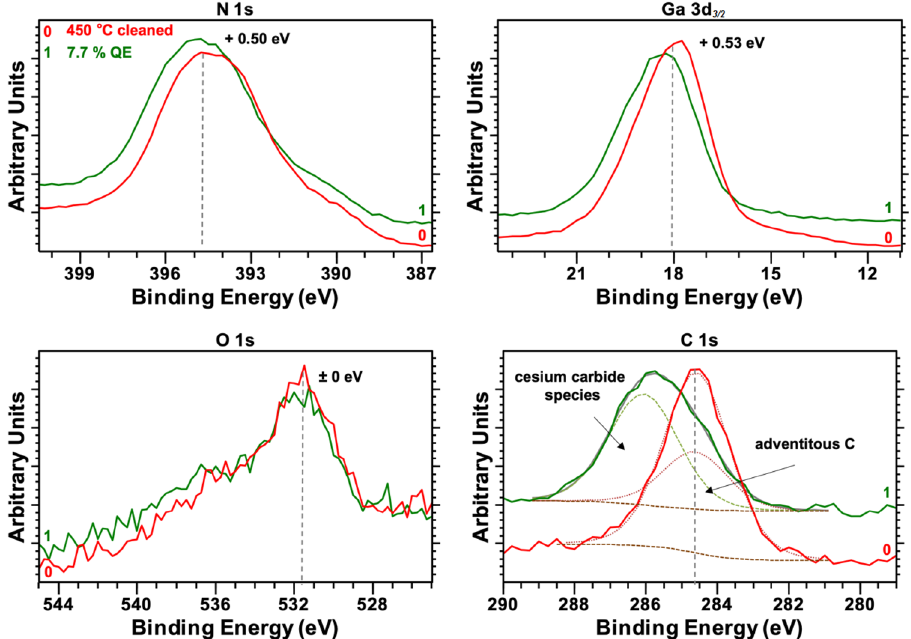
Figure 3. Ga 3d 3/2 , N 1 s, O 1 s, and C 1 s photoelectron spectra for the p-GaN surface after thermal cleaning at 450 °C (line 0) and after Cs activation with 7.7% QE (line 1). Dashed lines represent the peak fitting in the C 1 s spectra.